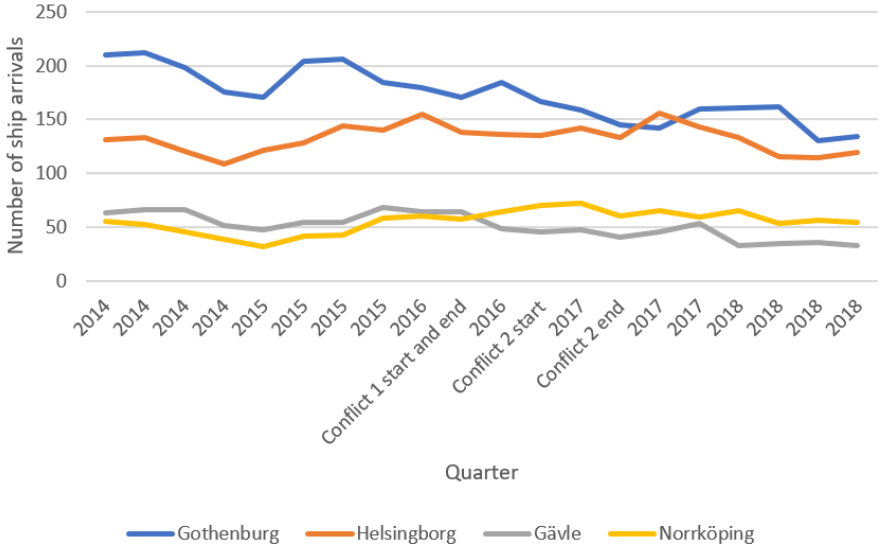
Figure 3. Number of Ship Arrivals to Each Port.